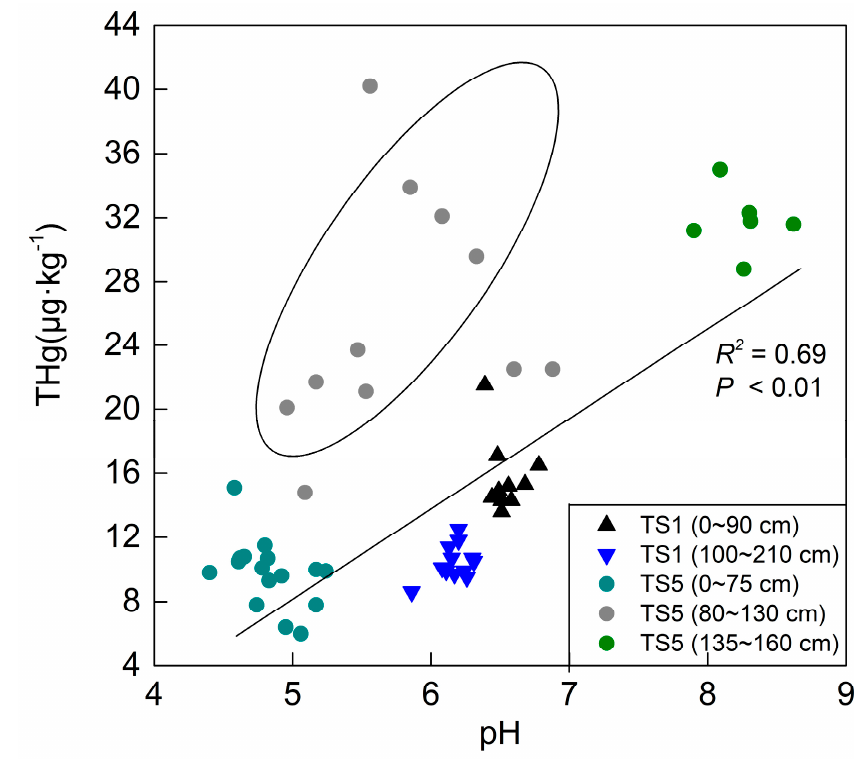
Figure 6. The correlation between pH and THg in the agricultural land.